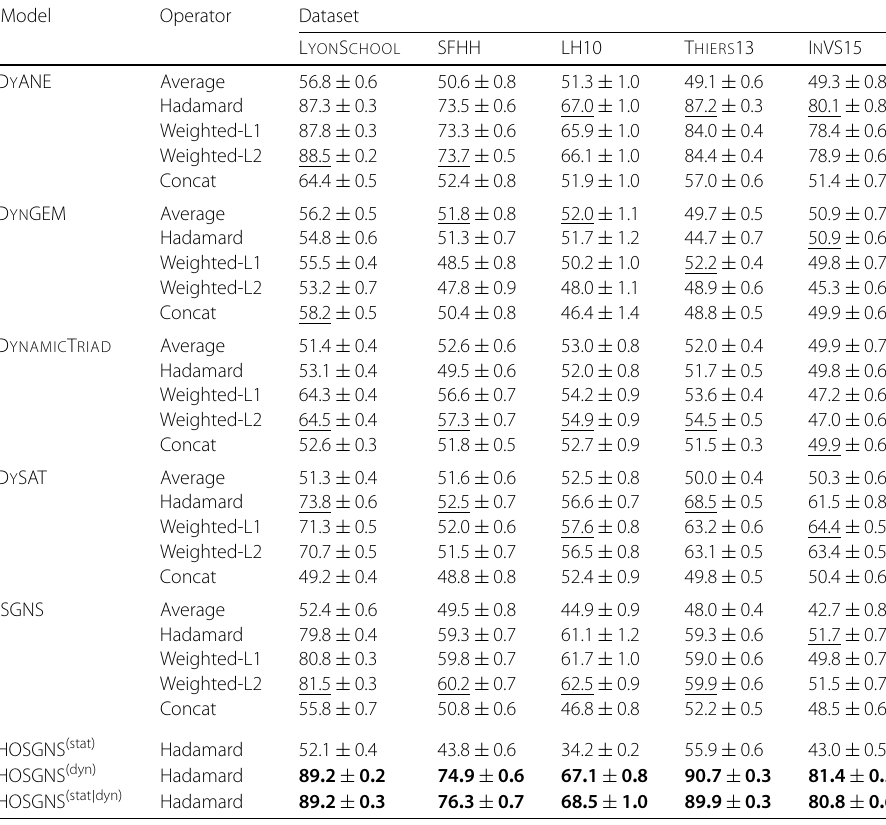
Table 4 Macro-F1 scores for missing event prediction in empirical datasets. We highlight in bold the two best scores for each dataset. For baseline models we underline their highest score